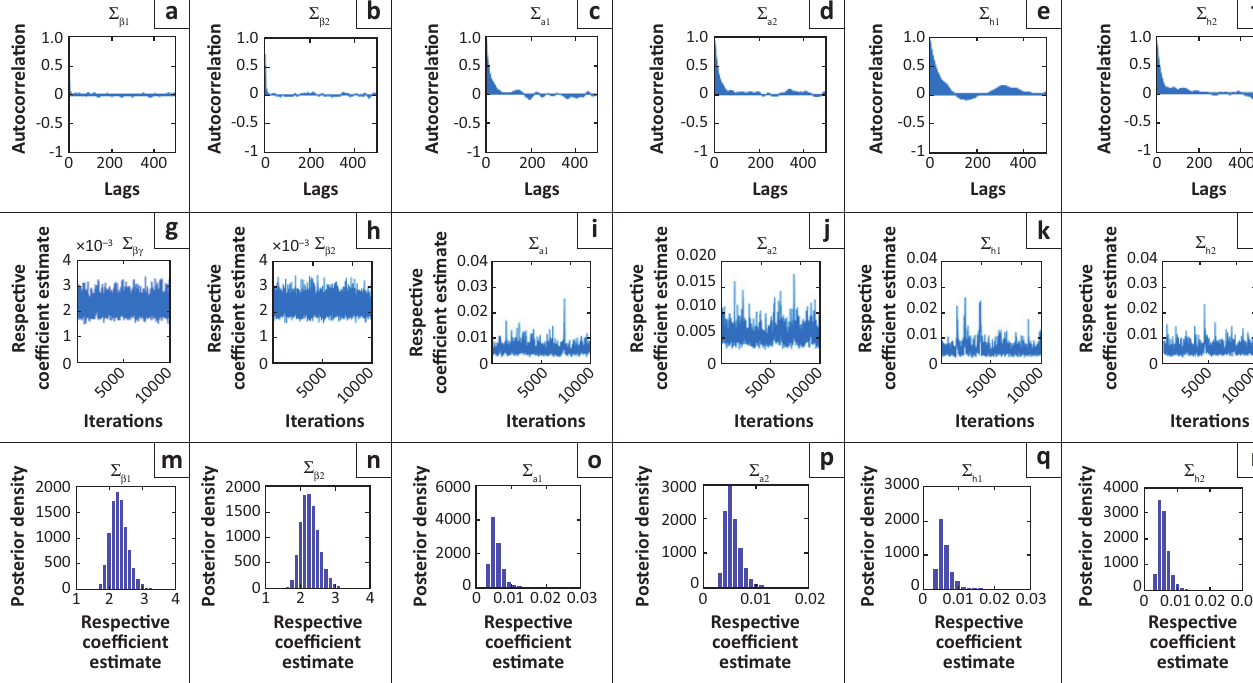
FIGURE 4: Sample autocorrelations (a–f), sample paths (g–l) and posterior densities Figure 4 and Table 1 output the estimation results for selected parameters in the TVP VAR model specified above. Figure 4 illustrates the sample autocorrelation function, the sample paths and the posterior densities for selected parameters. Inspecting the figure reveals stable sample paths and stable decaying autocorrelation functions, after discarding the sample in the burn-in period (initial 1000 samples). This implies that uncorrelated samples are efficiently produced by the sampling method. Table 1 shows the estimates for posterior means, standard deviations, the 95 % credible intervals (describes the uncertainty of the parameters), the Geweke (1992) convergence diagnostics (CD) and the inefficiency factors. The Geweke CD analyses individual chains by dividing the chain into two ‘windows’ containing a set fraction of the first and last iterations, dropping out the middle iterations.